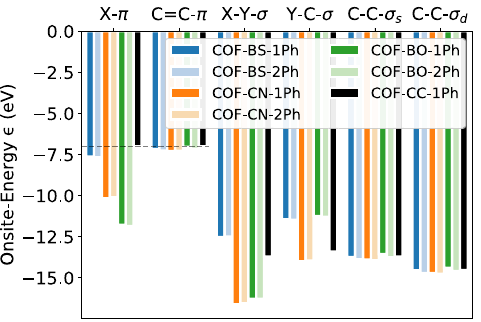
Figure 7. Orbital onsite energies for every WO and material. C-C- σ s and C-C- σ d denote the C-C- σ orbitals at single and double bond positions, respectively.